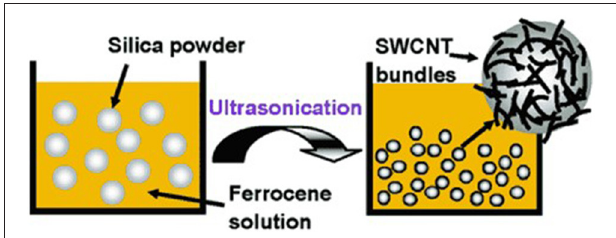
FIGURE 1 | Sonochemical processing of SWCNTs. Shows that silica powder in a solution of the ferrocene-xylene combination was sonicated for 20min under atmospheric pressure. Sonication produces highly pure SWCNTs on the surface of the silica powder.